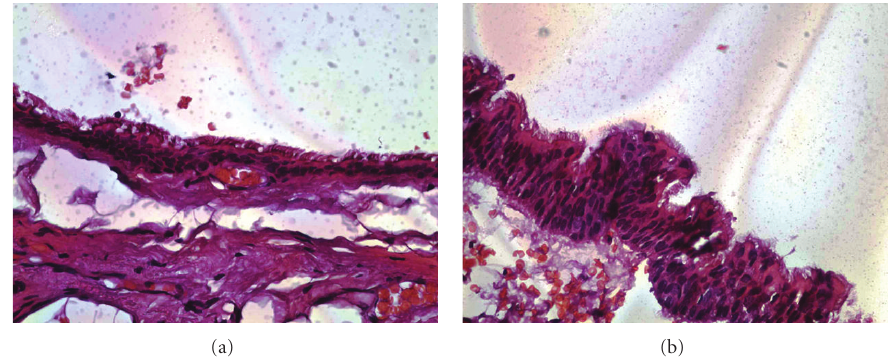
Figure 3: (a) Type A neurenteric cyst composed of respiratory epithelium with a basement membrane supporting pseudo stratified ciliated columnar epithelium at low magnification. (b) Type A neurenteric cyst composed of respiratory epithelium with a basement membrane supporting pseudo stratified ciliated columnar epithelium at high